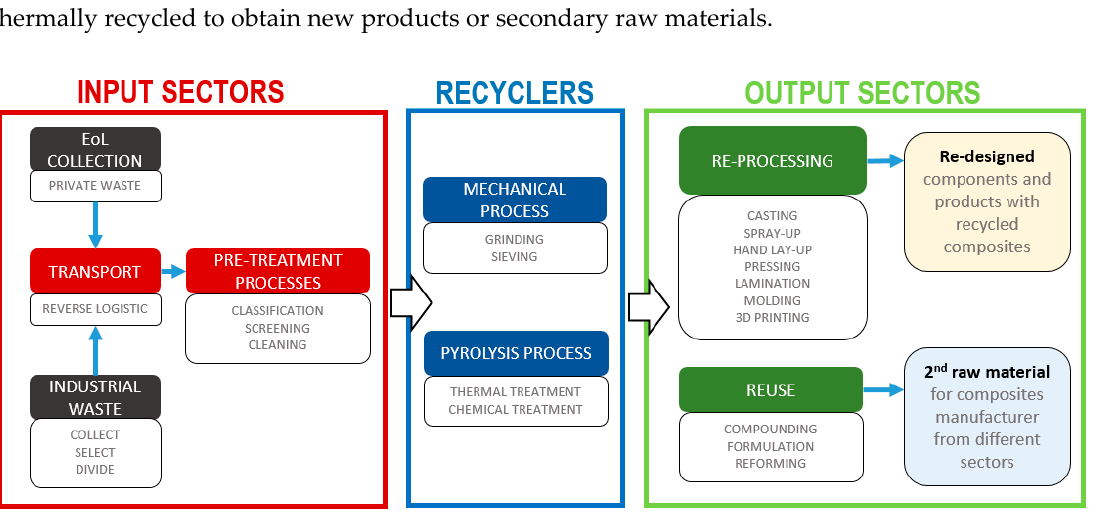
Figure 4. Ideal circular value-chain for composites and techno-polymer